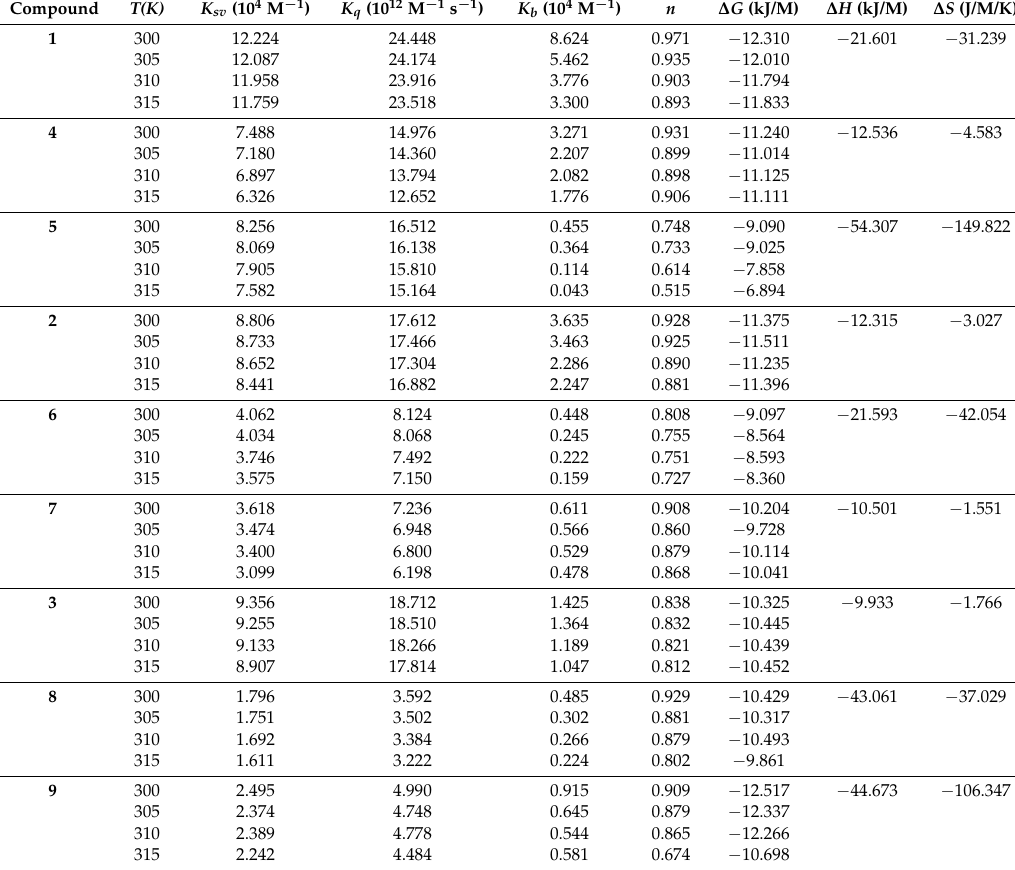
Table 1. Quenching ( K sv ) and binding ( K b ) constants and thermodynamic parameters ( n , ∆ G , ∆ H and ∆ S ) of the tested compounds and human serum albumin at different temperatures.